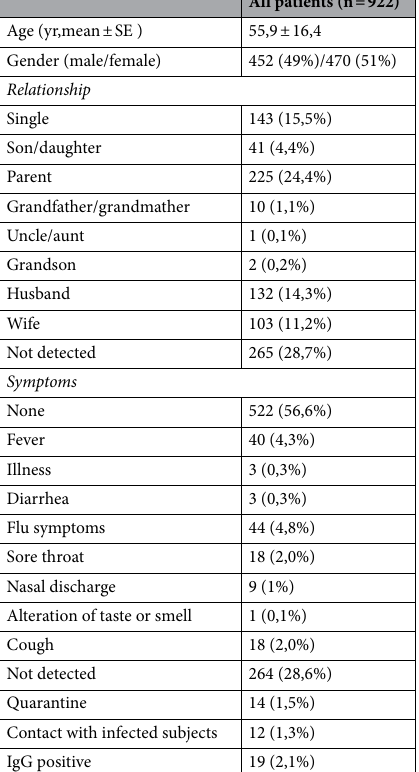
Table 1. Characteristics of the study group.